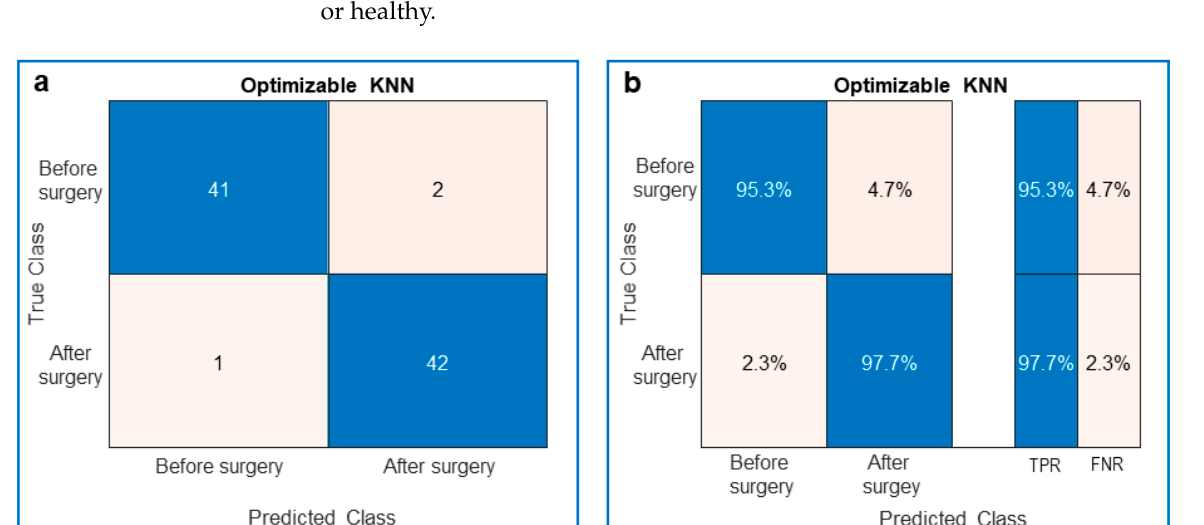
Figure 2. Performance of the trained optimizable k-nearest neighbor (KNN) classifier. ( a ) Confusion matrix showing the true and predicted classes of the ToF patients’ videos. The blue diagonal is related to the number of videos that were truly recognized (Predicted Class = True Class), whereas the pink antidiagonal is related to the number of videos that were falsely recognized (Predicted Class ≠ True Class). ( b ) Same as ( a ) with the True Positive Rate (TPR) in blue and the False Negative Rate (FNR) in pink.